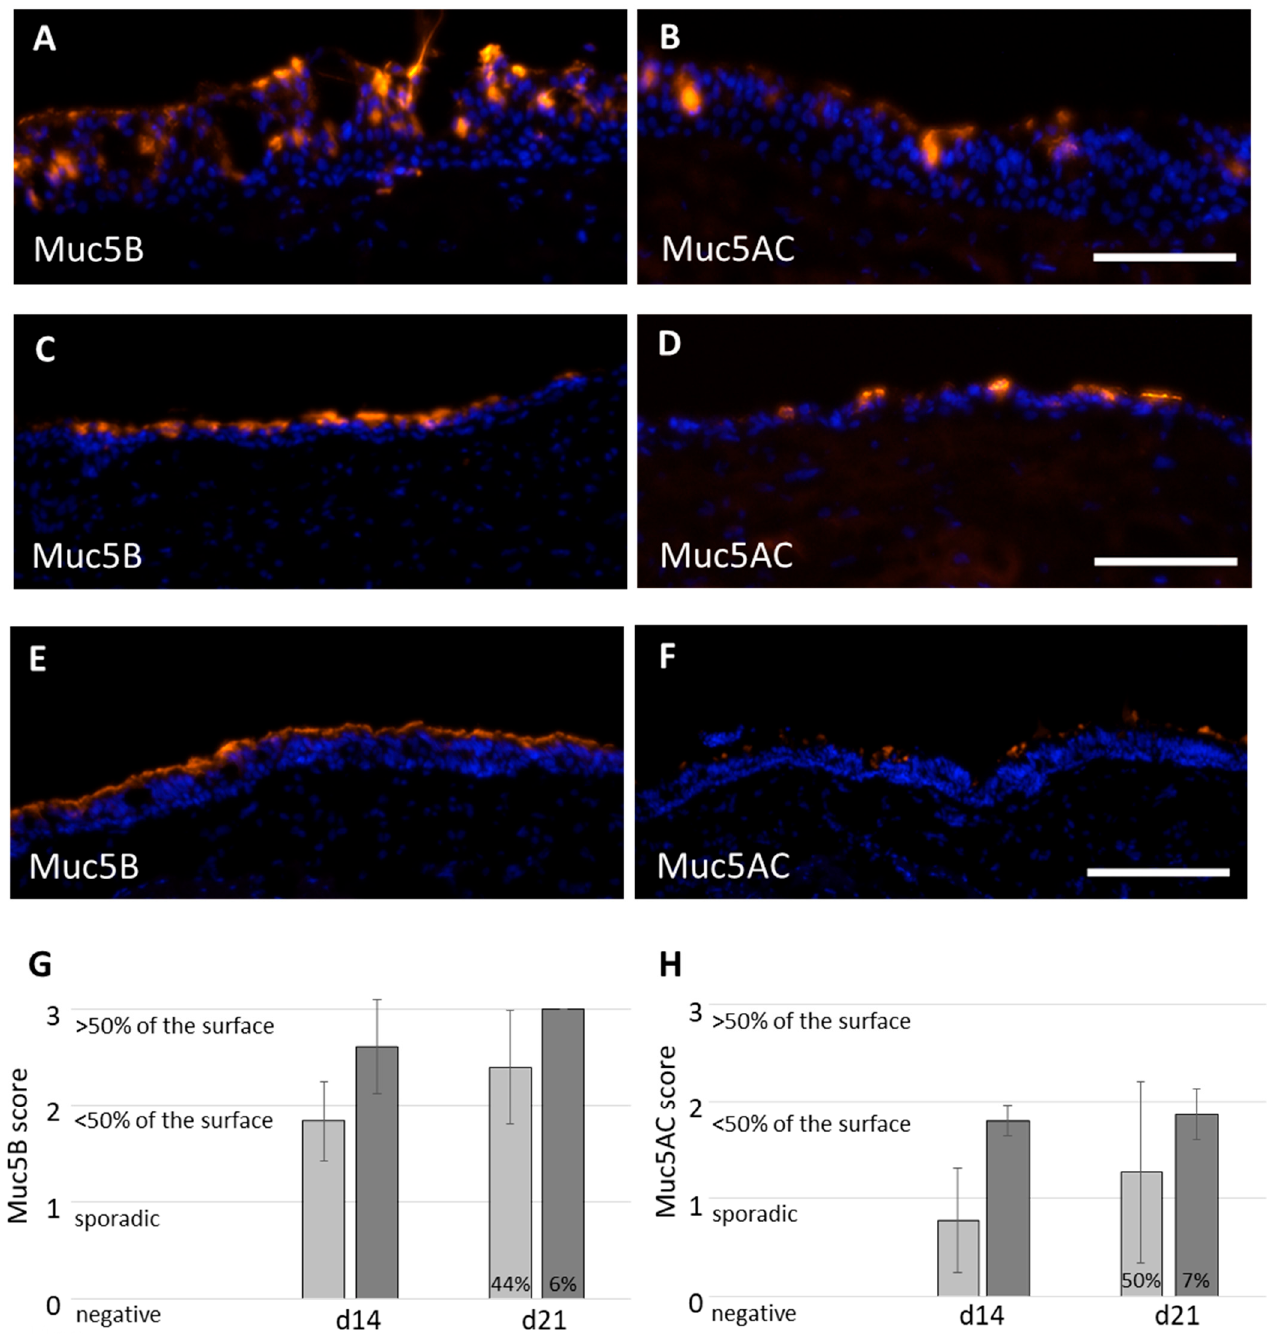
Figure 4. Mucus production in 3D airway tissue models. Immunofluorescence stainings of cross sections of 21 days old ALI models against Muc5B (orange, ( A , C , E )) and Muc5AC (orange, ( B , D , F )) cultivated with (( A , B ), n = 9 from four donors) AECG and (( C , D ), n = 6 from four donors) PC ALI medium. ( E , F ) staining of native bronchus (control). The amount of Muc5B ( G ) and Muc5AC ( H ) was scored (Muc5B: AECG and PC ALI n = 6; Muc5AC: AECG n = 6; PC ALI n = 5, all from four donors) with AECG in light grey bars and PC ALI medium in dark grey bars. The percentage of cross sections containing intraepithelial mucus cysts is shown within the bars at day 21. Nuclei were stained with DAPI (blue). Scale bar: 200 µ m. Shown are the mean average with standard deviation.